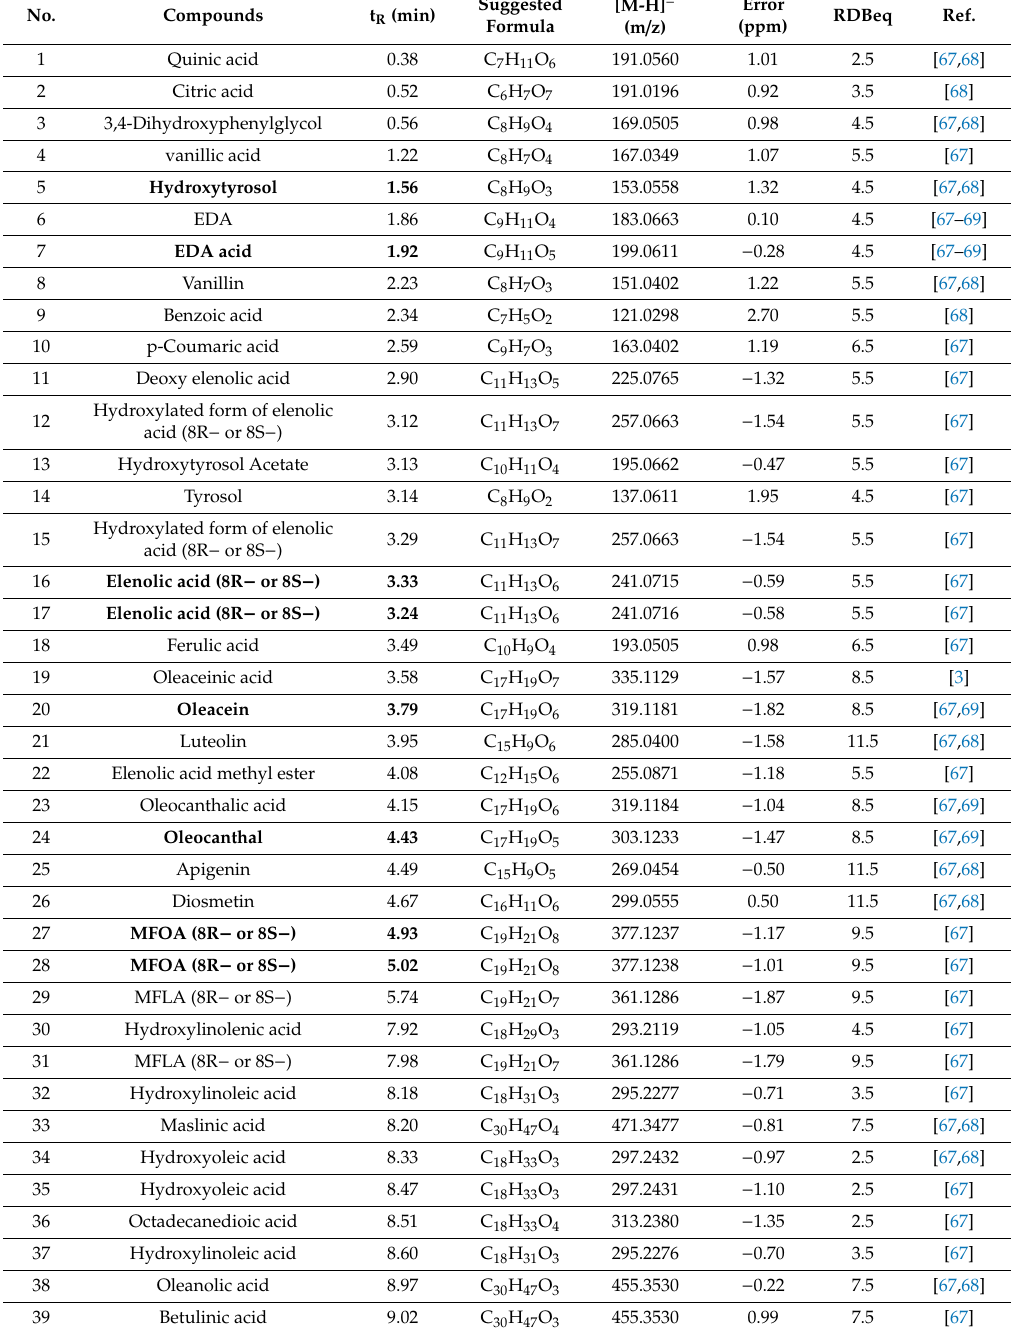
Table A1: Secondary metabolites identified in the TPC extract by UPLC-ESI(-)-HRMS / MS; Table A2: Secondary metabolites identified in the S. scardica water / ethanol extract by UPLC-ESI(-)- HRMS / MS; Table A3: Multivariate linear regression; Figure A1: Analysis of extract toxicity. Table A1. Secondary metabolites identified in the TPC extract by UPLC-ESI(-)-HRMS / MS.